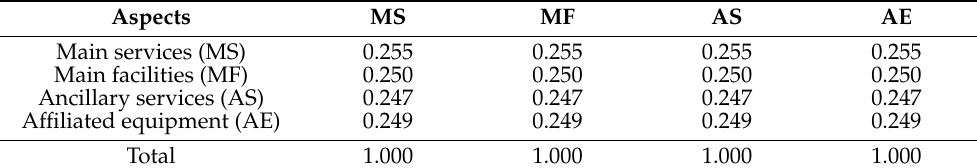
Table 12. Limited super-matrix.